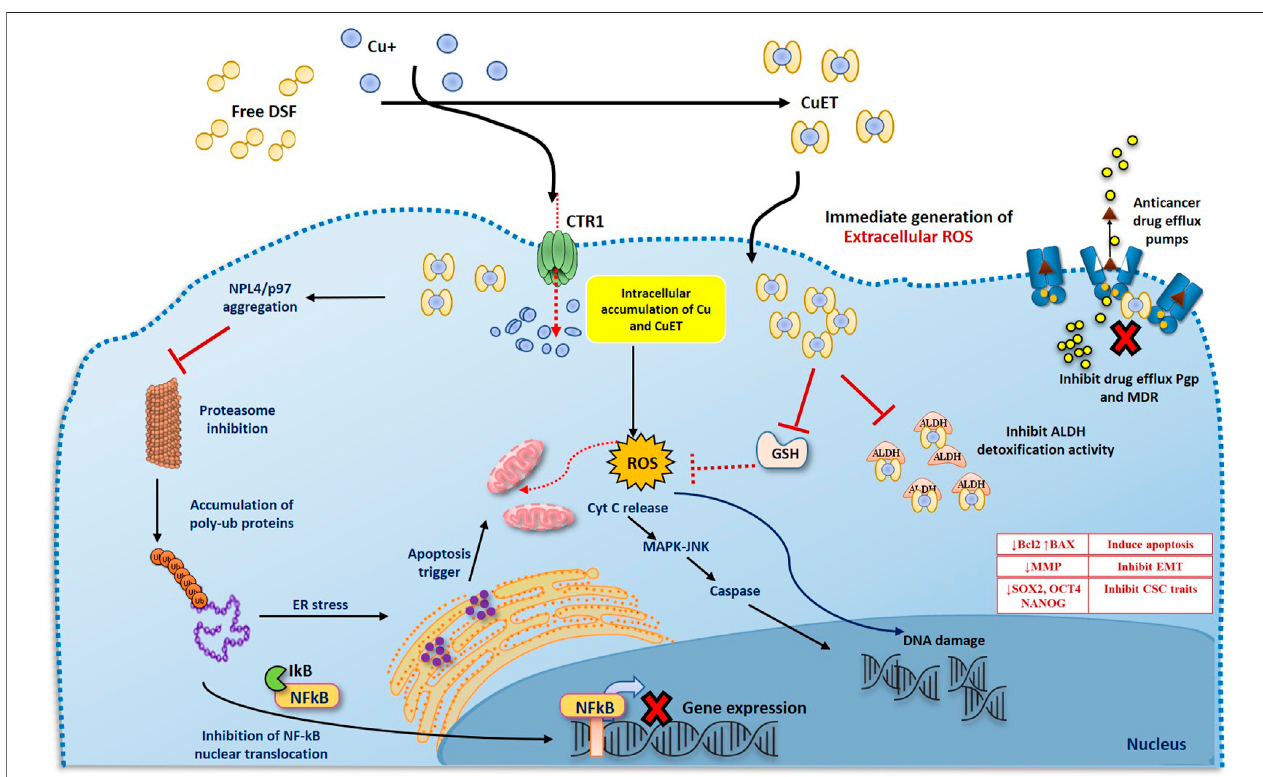
FIGURE 2| Two phases anticancer model ofDS and DDC plus copper induced cancer cell death. 1. DS or DDC and copper contact and react extracellularly. The reaction will generate ROS extracellularly which induce cancer cell apoptosis. Due to the extremely short lifespan of ROS in tissue, the reaction must be taken place adjacent to cancer cells, in order to effectively target cancer cells. 2. The reaction-generated compound, CuDDC 2 (CuET), can easily penetrate cancer cells and trigger intracellular ROS generation and induce cancer cell